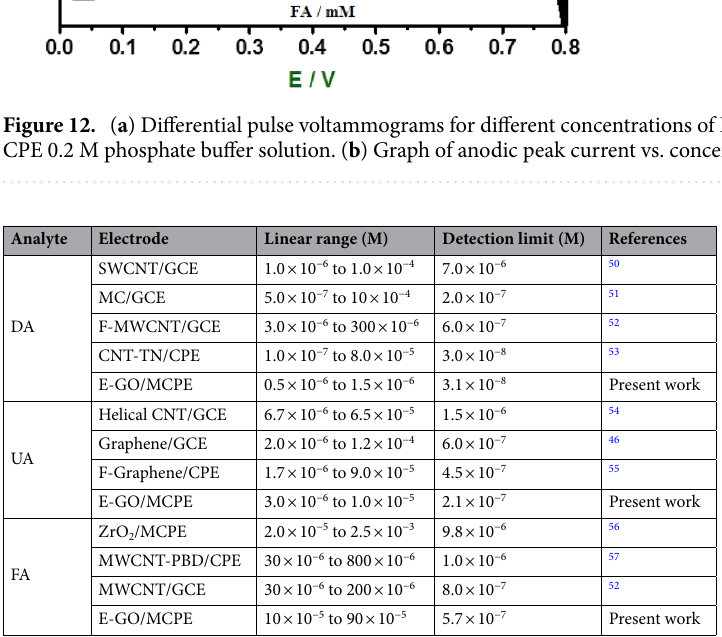
Table 2. Comparison of detection limits of DA, UA, and FA of E-GO modified CPE with other working electrodes.